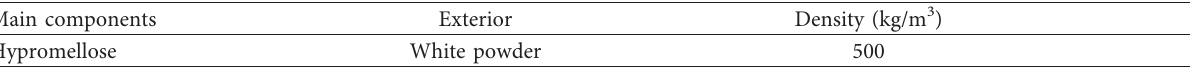
Table 4: Tackifier composition parameters.